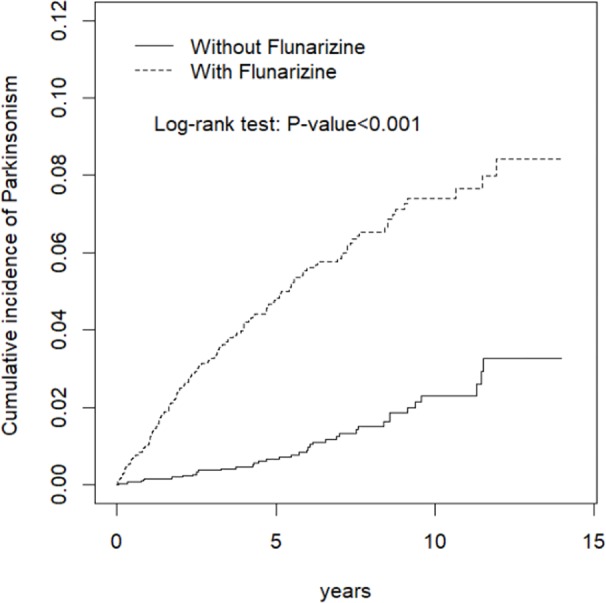
Kaplan-Meir method determined cumulative incidence of parkinsonism compared between Flunarizine cohort and comparisons without Flunarizine.